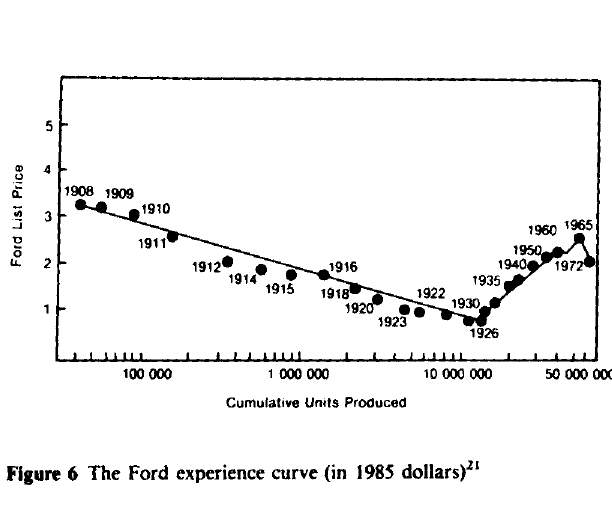
Figure 6 The Ford experience curve (in I 985 dollars)z,